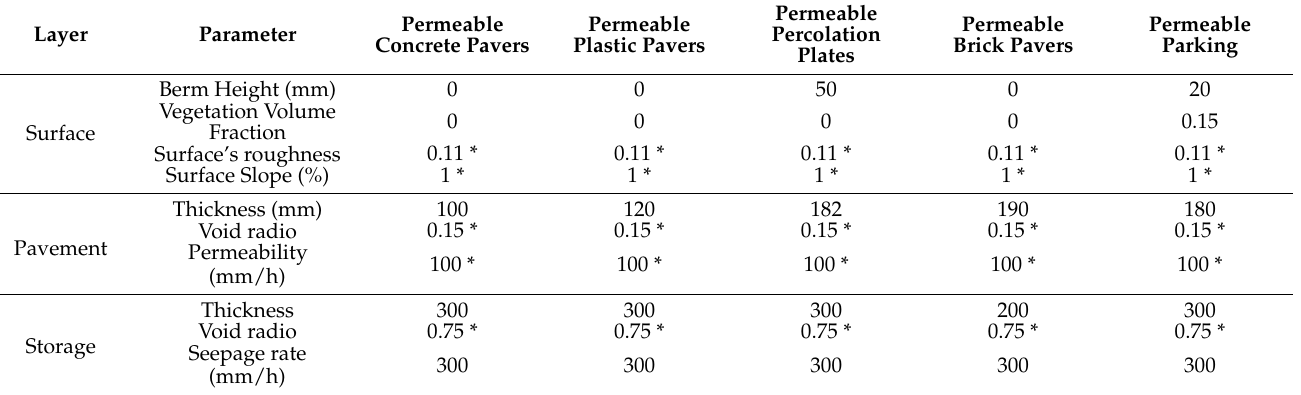
Table 2. Parameters of each permeable pavement.